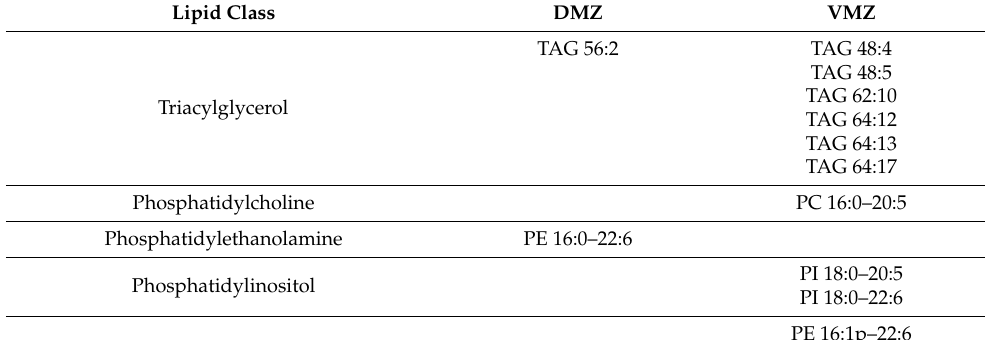
Table 1. Lipids detected only in the supernatants of the DMZ or VMZ